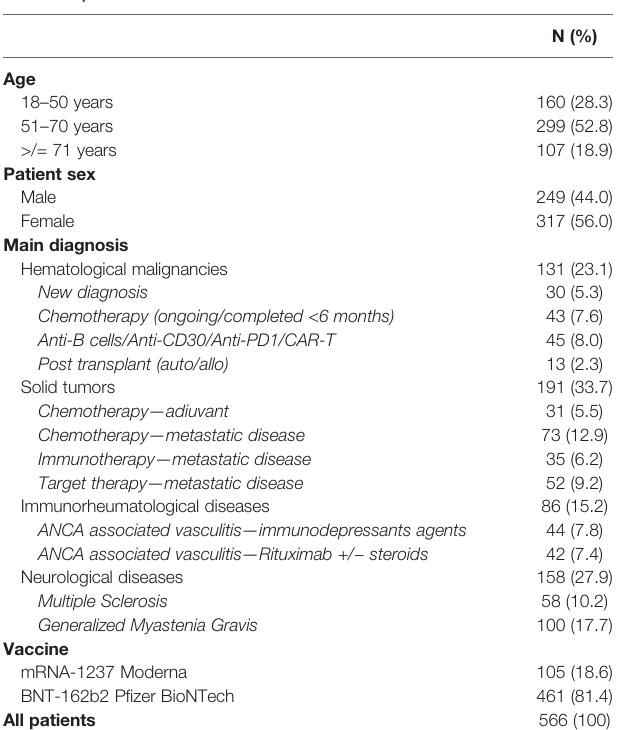
TABLE 1 | Patient ’ s